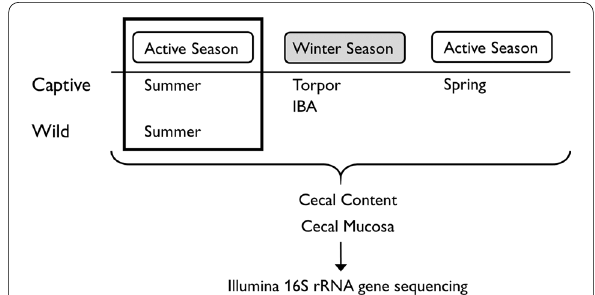
Fig. 5 Experimental design. Cecal content and mucosa were collected from summer captive and wild TLGS, as well as captive TLGS across the year. The black box indicates the two summer groups that were used in the comparison of Captive and Wild microbiotas. For the description of captive TLGS across seasons, four groups were used: Summer, Torpor, IBA, and Spring. Summer and Spring groups represent active seasons, while Torpor and IBA groups represent the winter